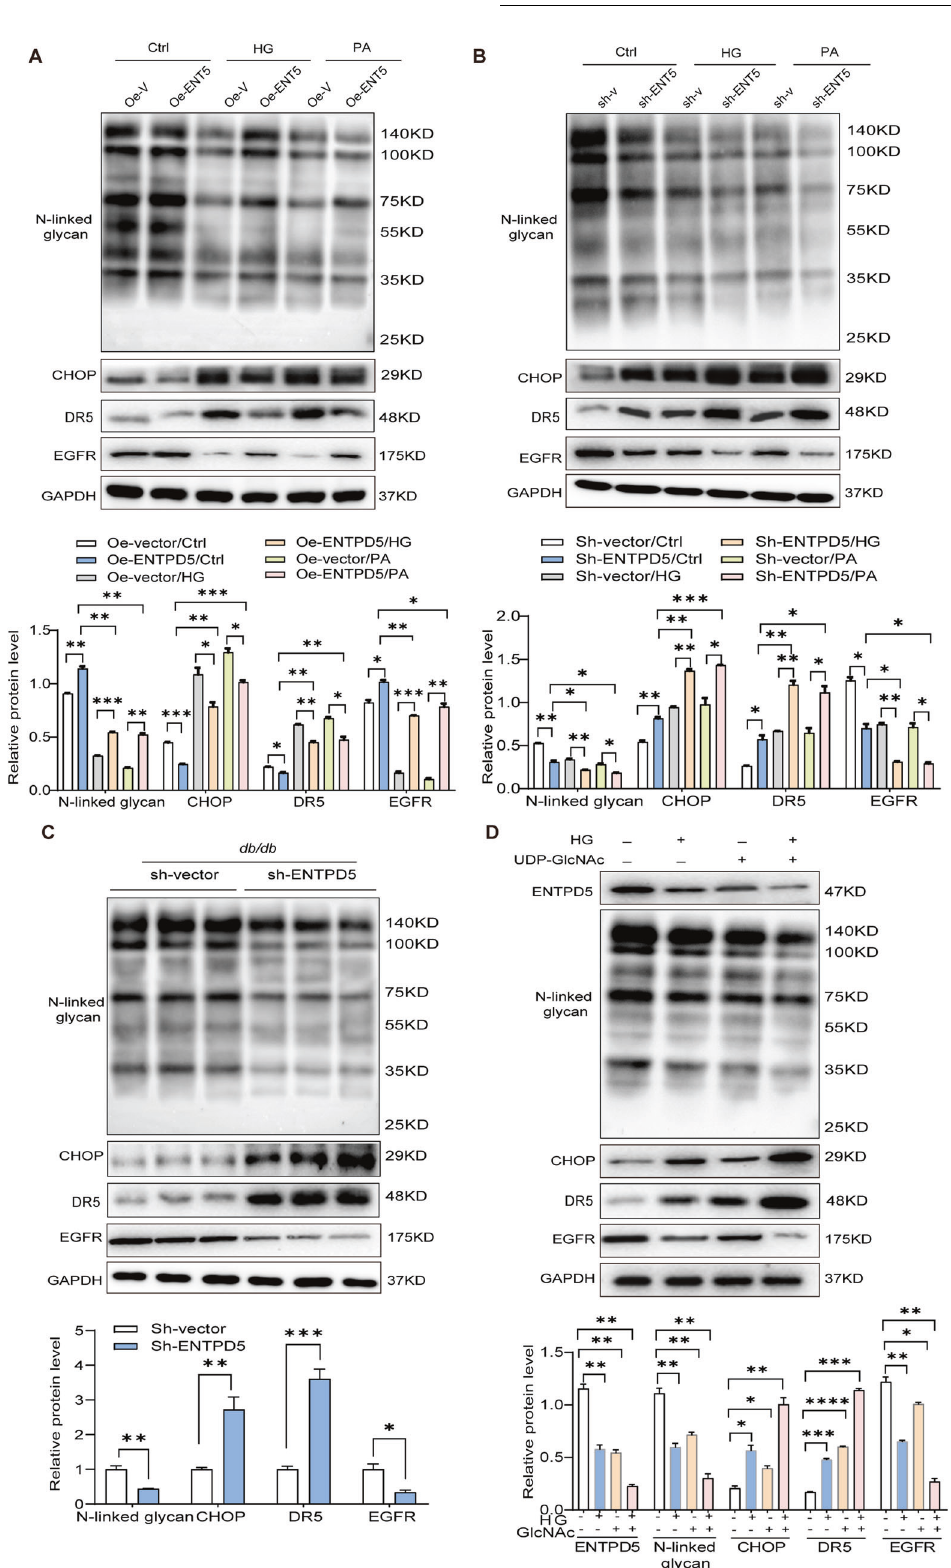
Fig. 4 ENTPD5 regulates ER stress-mediated cell proliferation and apoptosis through protein N-glycosylation. A Representative western blot and quanti fi cation of protein expression (N-GlcNAc, CHOP, DR5, and EGFR) in ENTPD5 overexpressing RTECs exposed to HG (30mmol/L) and PA (0.2mmol/L) for 48h ( n = 3 blots). B Representative western blot and quanti fi cation of protein expression (N-GlcNAc, CHOP, DR5, and EGFR) in ENTPD5 knockdown RTECs exposed to HG (30mmol/L) and PA (0.2mmol/L) for 48 h ( n = 3 blots). C Representative western blot and quanti fi cation of protein expression (N-GlcNAc, CHOP, DR5, and EGFR) in the kidneys of ENTPD5 knockdown db/db mice ( n = 3 blots). D Representative western blot and quanti fi cation of protein expression (ENTPD5, N-GlcNAc, DR5, CHOP, and EGFR) in RTECs exposed to NG (5.5mmol/L) and HG (30 mmol/L) plus N-glycosylated substrate UDP-GlcNAc (10mmol/L) for 48 h ( n = 3 blots). Data are mean ±SD. * P <0.05, ** P <0.01, *** P <0.001, **** P <0.0001. Cell Death and Disease (2023)